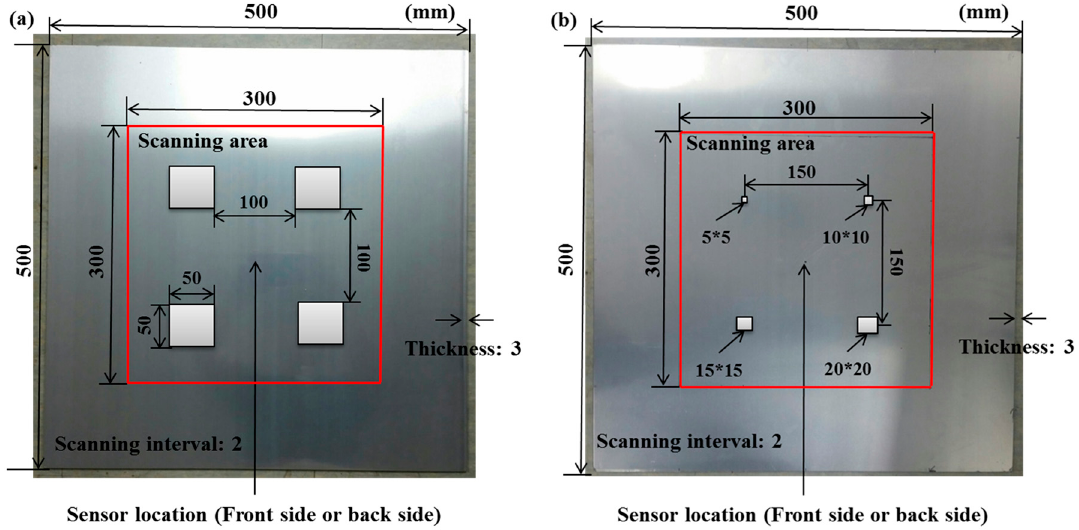
Figure 3. Sensor locations and scanning areas of the aluminum plate for laser scanning targets (all distances in millimeters): ( a ) intact Specimen 1; ( b ) intact Specimen